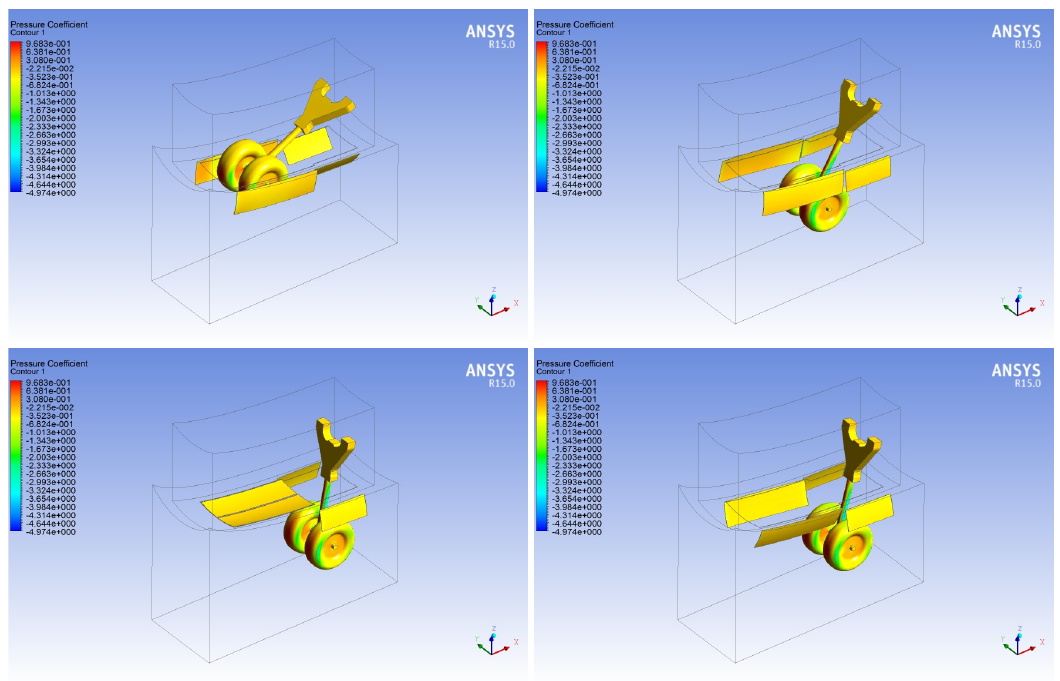
Figure 9. NLG: pressure distribution during the lowering phase (clockwise), for the case